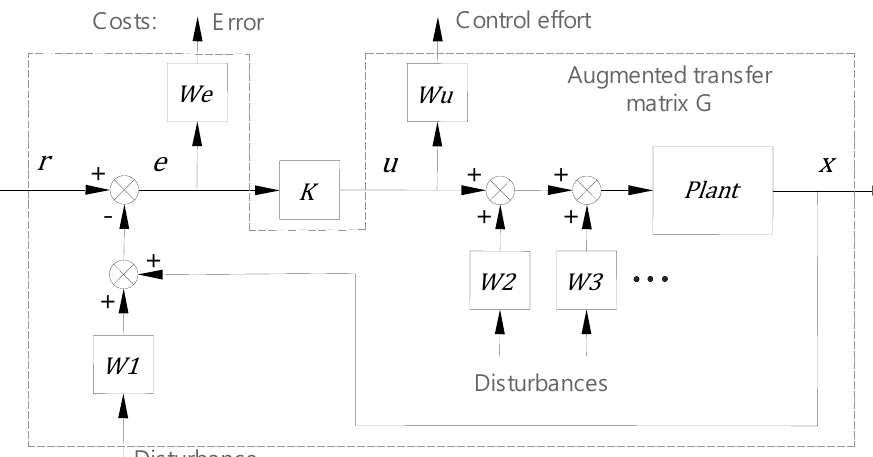
Figure 4. Augmented plant configuration for optimal controller design.